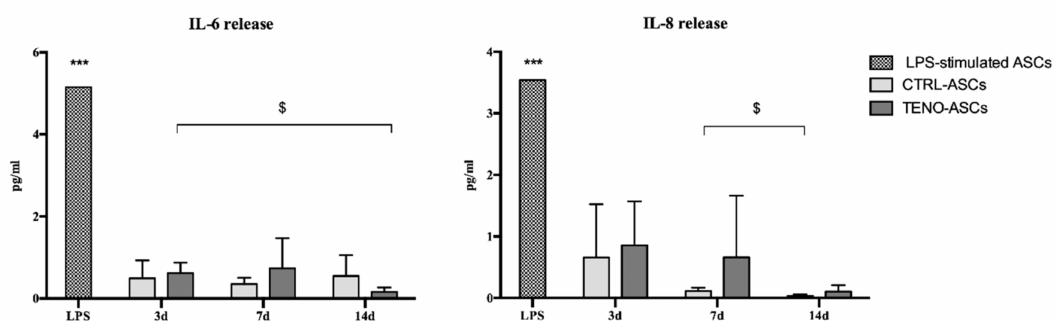
Figure 8. ASC cytokines release in the 3D NFC / A cultures. IL-6 and IL-8 release obtained by the supernatant media collected after 3, 7 and 14 days of both undi ff erentiated (CTRL) and di ff erentiated (TENO)ASCconstructs( N = 3). PositivecontrolwasobtainedfromsupernatantmediaofASCconstructs treated with LPS for 24 h. Level of significance *** p < 0.001 vs. the respective no-LPS-stimulated ASC constructs, $ p < 0.05 vs. time